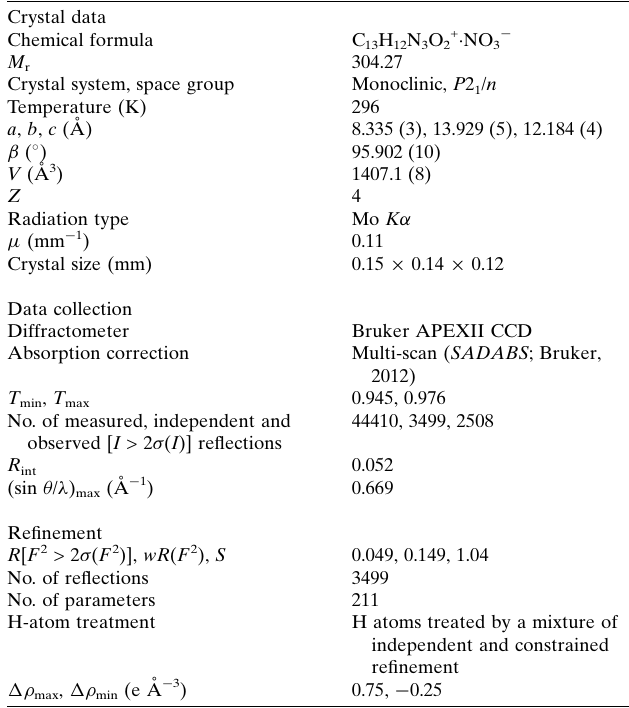
Crystal data Chemical